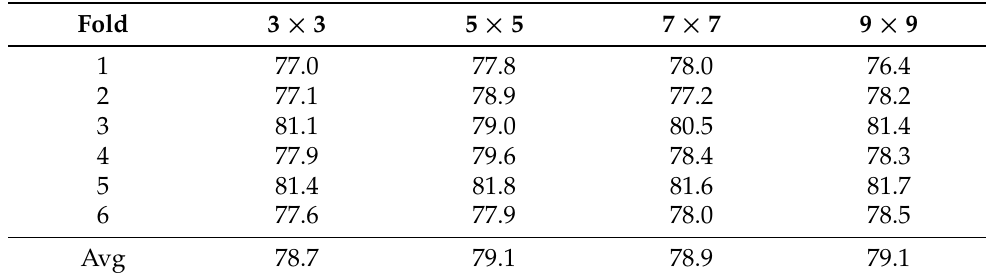
Table 16. Overall accuracies obtained by the proposed DRIN with different involution kernel sizes for six non-overlapping training–test splits on SV